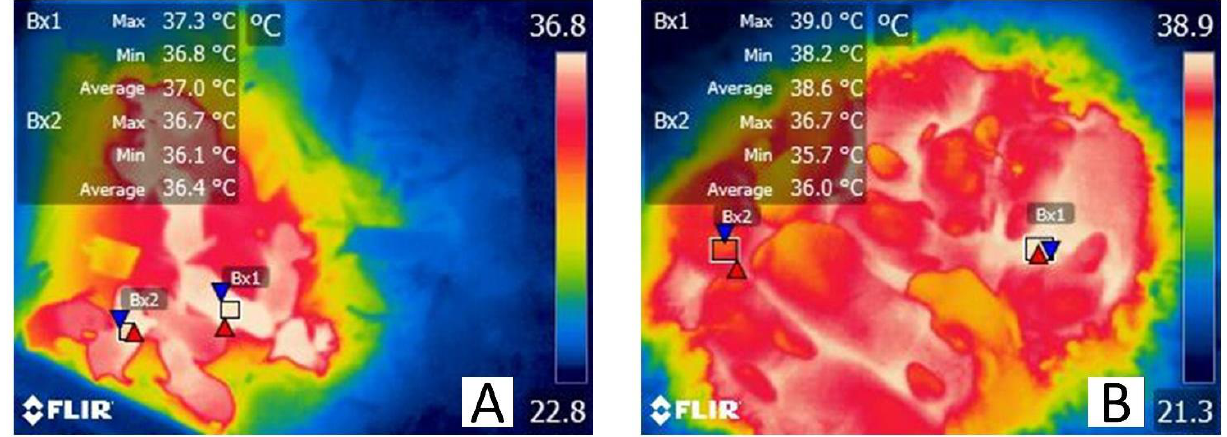
Figure 3. Huddling behavior in newborn Wistar rats ( R. norvegicus ) and New Zealand rabbit pups ( O. cuniculus ). ( A ) Thermoregulatory effect of huddling and the influence of the position within the nest in 1-day-old rat pups. The surface temperature of one of the rats in a central position, measured in the dorsal interscapular region (Bx1), shows a maximum, a minimum, and an average temperature of 37.3, 36.8, and 37.0 °C, respectively. In contrast, the temperatures of one rat pup in the nest periphery (Bx2) registered a maximum value of 36.7 °C, a minimum of 36.1 °C, and an average of 36.4 °C. ( B ) 1-day-old New Zealand rabbit pups huddling with conspecifics (Bx1) in a central position are observed as a white tone in the thermogram. A reddish-yellow tone is observed in newborn rabbits positioned in the group periphery (Bx2). Between central and peripheral positioned rabbit neonates, a difference of up to 2.3 °C in the minimum temperature (39 vs. 36.7 °C) and an average difference of up to 0.6 °C were recorded. These values measured through infrared thermography provide information on the importance of neonate rodents and leporids' behaviors to preserve heat and to maintain a stable body temperature. The authors took the thermographic images with a FLIR E80 camera with an 18 mm FOL lens at a resolution of 320 × 240 pixels and the ability to accurately measure temperatures from −20 °C to 550 °C/−4°F to 1022°F (emissivity = 0.95, distance = 30 cm).